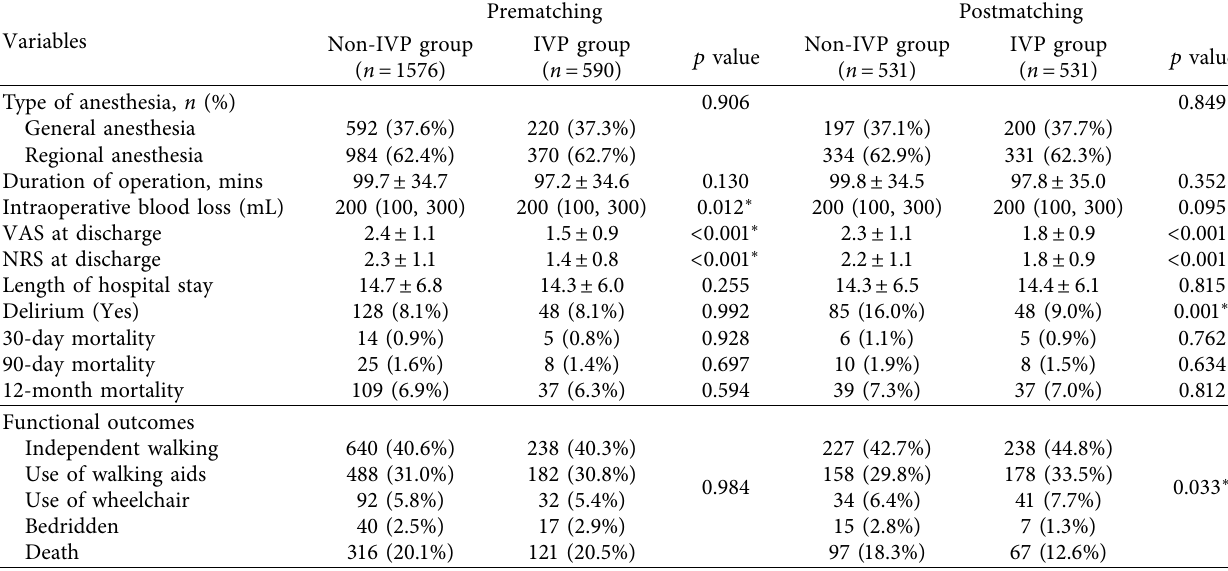
Table 2: Patient outcome analyses before and after propensity score matching.